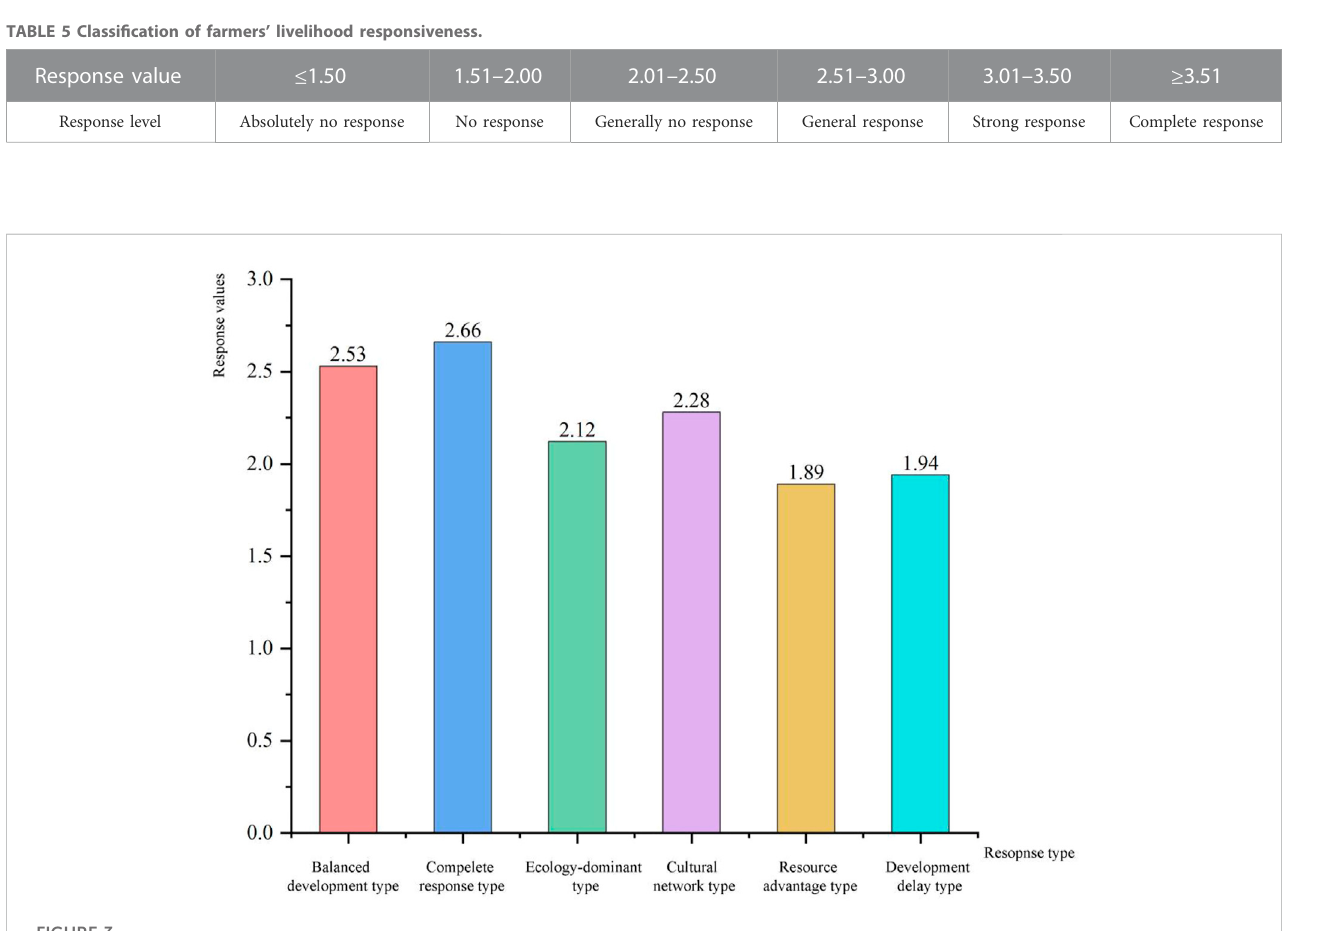
culture (2.85872) and social connection (0.67530) factors had high scores and were deemed the “ cultural network type. ” In cluster 5, the economic ecology (0.65471) and natural resource (0.25878) factors had high scores, which re fl ected the “ resource advantage type. ” In